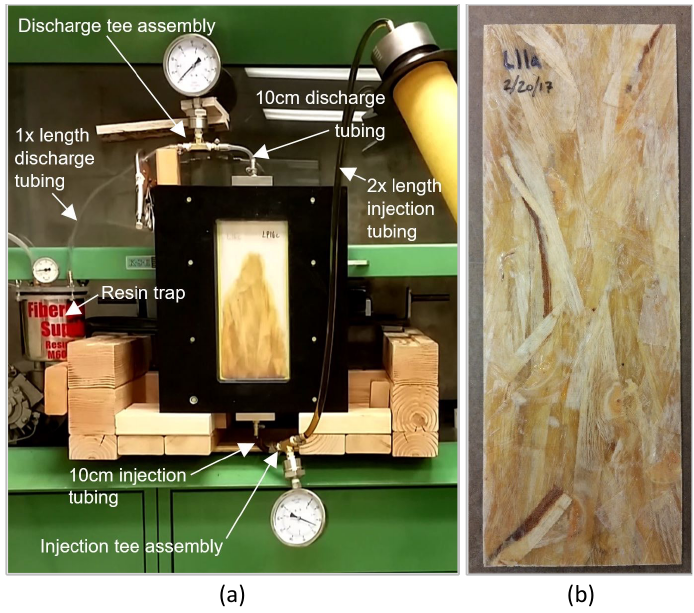
Figure 2. ( a ) RTM injection setup during resin infusion, and ( b ) a cured and trimmed molded pan- el.